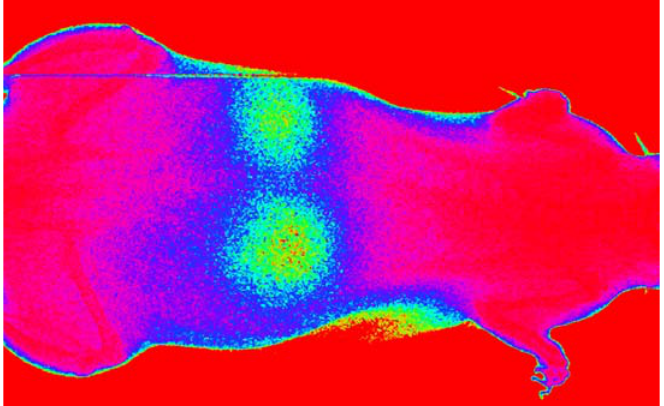
FIGURE 2 - Baseline (initial) scintigraphic image, captured before I/R, from control group rat. No difference in the radiotracer uptake was observed comparing the right and left kidneys.